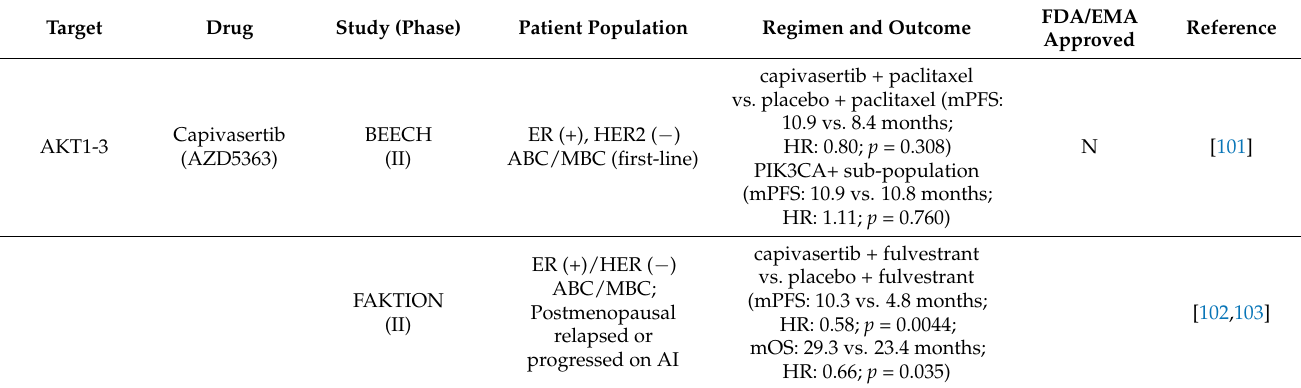
Table 3. Clinical trials of AKT and mTOR inhibitors in ER+/HER2 − breast